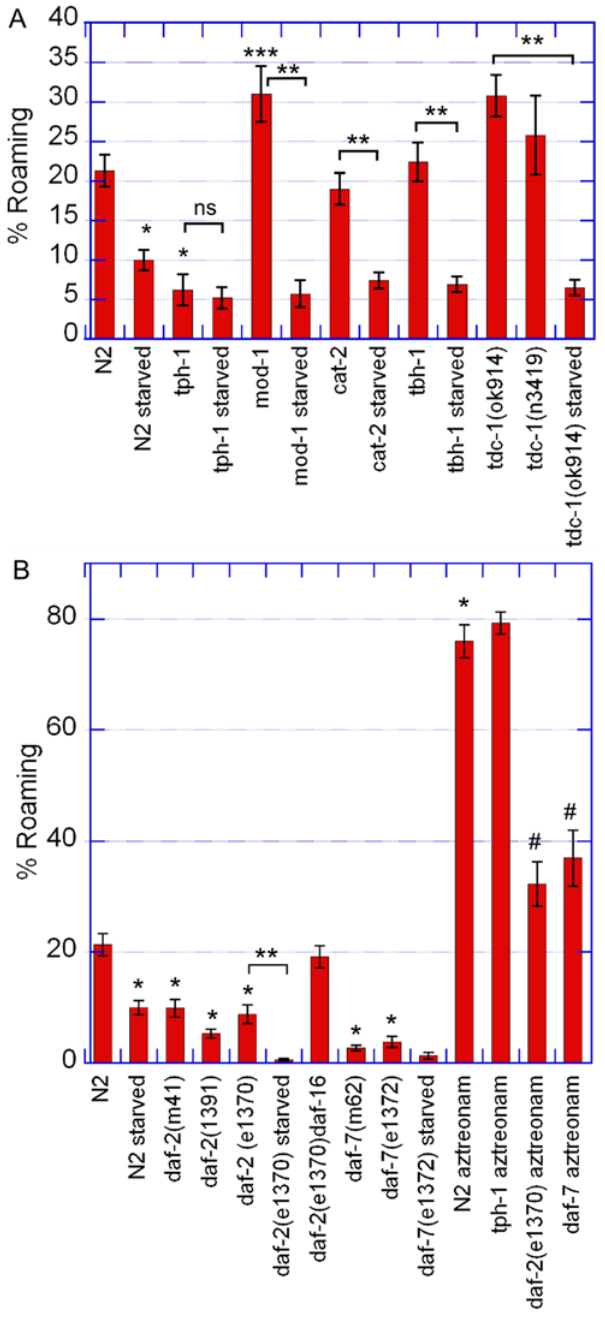
Figure 4. Biogenic amines, insulin and TGF-beta signaling mutants. (A) Percentage of time spent roaming for well-fed and fasted biogenic amines mutants in standard conditions. (B) Percentage of time spent roaming for well-fed and fasted insulin and TGF beta signaling mutants in standard conditions and on aztreonam-treated OP50. At least 20 worms were recorded per condition. Results are presented as mean 6 s.e.m. *Different from wild type, Student’s t-test p , 0.01. ***Different from wild type p , 0.05. **Different from each other p , 0.01. # Different from wild type on atreonam treated bacteria p , 0.01.